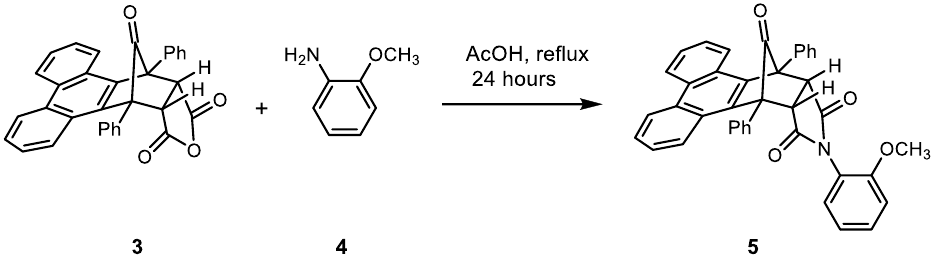
Figure 1. “ U nfolded” and “folded” conformers of maleimide 5 (the CH –π interaction is indicated on 5b as a dashed line). 2. Results Phencyclone 1 readily reacts with maleic anhydride 2 in refluxing benzene or toluene, however, toluene was preferred for use in this work. The reaction is usually complete within 20 – 30 min, the end point is readily identified since phencyclone forms a dark green solution in toluene, which fades as the starting material is consumed. Phencyclone can be purchased from commercial suppliers, alternatively, it can easily be prepared from 1,3- diphenylacetone and 9,10-phenanthraquinone [7,8]. Cycloadduct 3 can be stored in a cool, dark place for several years without significant decomposition, however, it is not stable if heated to melting point. Under these conditions, decomposition will occur, and the vig- orous release of CO gas will take place as soon as the melting point is reached [1]. The stability of 3 is also limited if stored in hygroscopic solvents, on prolonged storage, the hydrolysis of the cyclic anhydride can take place. Material that was satisfactory for study by X-ray crystallography was obtained by dissolving samples of compound 3 (0.05 – 0.1 g) in ethyl acetate (5 – 10 mL). Where neces- sary, the mixtures were heated to ensure that all the solid material had dissolved. The samples were stored for several days, until suitable crystals were formed and isolated. The crystal structure of 3 (Figure 2) confirms the results from earlier studies that the com- pound is isolated as the endo -isomer [1,2]. As noted above, cycloadduct 3 releases carbon monoxide gas when heated to the melting point, and this phenomenon is known to occur in other phencyclone cycloadducts [8,9] and it is attributed to a cheletropic CO extrusion reaction. In a published study, crystallography techniques were used to survey certain structural characteristics of bridged cyclopentenones and comparisons were made to their reactivity in cheletropic decarbonylation reactions [9]. It was concluded that the C=O and highlighted C – C bond distances in bridged cyclopentenones can be useful indicators of the potential for cheletropic decarbonylation to take place. The survey of bridged cyclo- pentenone structures indicated that C-C bonds broken during the cheletropic reaction are typically longer than those expected for the associated cyclopentanone. In contrast, the C=O bond (that can be lost as CO) is shorter than would be expected in the corresponding